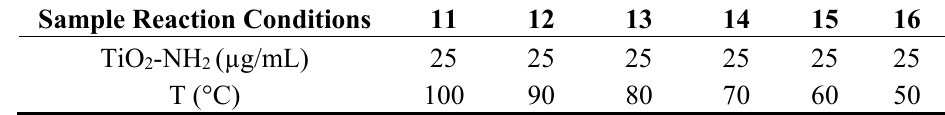
Table 2. Reaction temperatures and amount of TiO 2 -NH 2 particles used in the syntheses